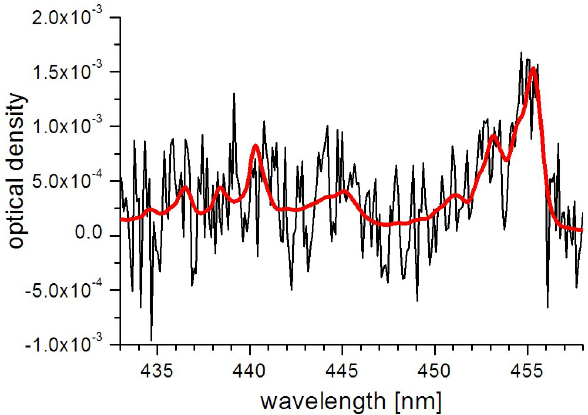
Fig. 1. Spectral retrieval for elevated CHOCHO (dSCD of 2.69 × 10 15 molec/cm 2 and RMS of 0.37 × 10 − 3 ) . The example spectrum was recorded on 28 December 2008 at 03:29p.m. UT at an elevation angle of 179.4 ◦ . The optical density of CHOCHO ver- sus wavelength is shown in red, whereas the black line shows the sum of the scaled cross section and the